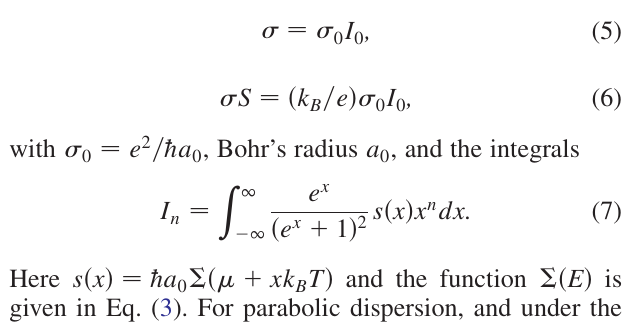
, m ), and ratios between the maxi- e h